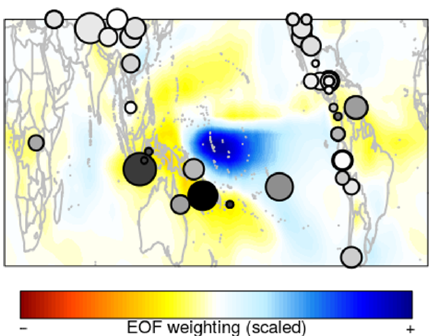
Figure 5. Precipitation EOF with proxy locations. Background colours are scaled EOF values. Bubbles are individual proxies; size is indicative of how often the proxy is included in the network en- semble, and shading indicates relative weighting such that darker colours are more strongly positive or negative.